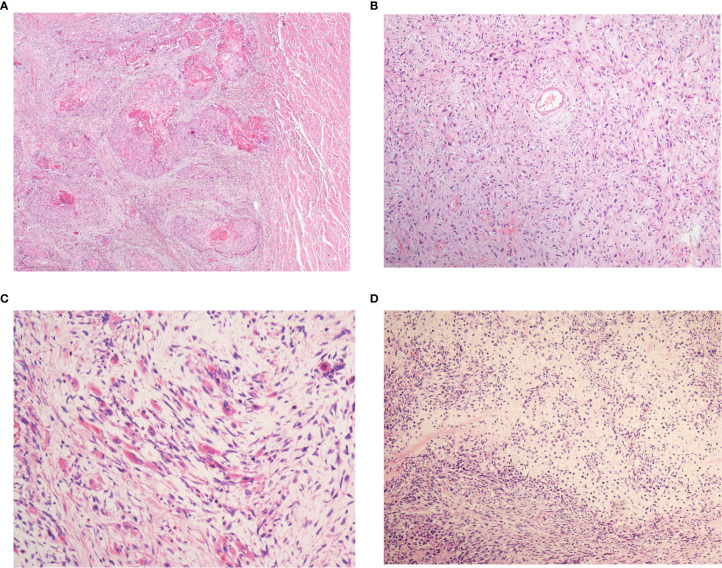
The histopathological patterns of esophageal spindle cell squamous cell carcinoma. All patients in the present study were composed of neoplastic squamous epithelium (A) and spindle-shaped sarcoma (B). Definite mesenchymal differentiation, such as that in rhabdomyosarcoma (C), chondrosarcoma (D), is occasionally observed in the spindle cell components.